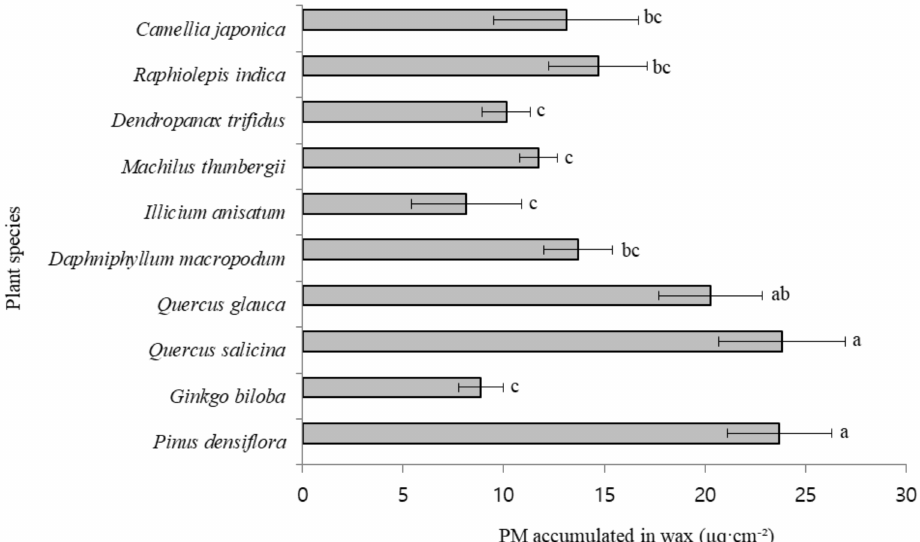
Figure 4. Total particulate matter (PM) accumulated in wax layer of leaves of eight evergreen and two coniferous species. Data presented as mean ± SD, n = 30. Bars marked with different letters are significantly different by Duncan multiple test ( p < 0.05).